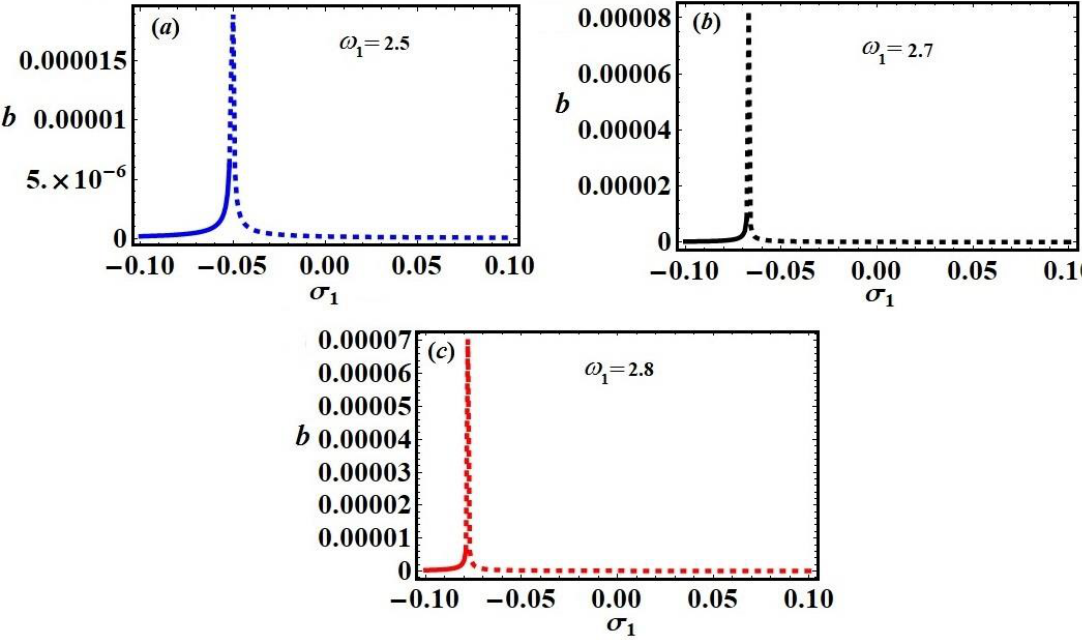
Figure 11. Frequency response curves of the amplitude b at c 1 = 0.03, σ 2 = 0.003: ( a ) ω 1 = 2.5, ( b ) ω 1 = 2.7, ( c ) ω 1 =